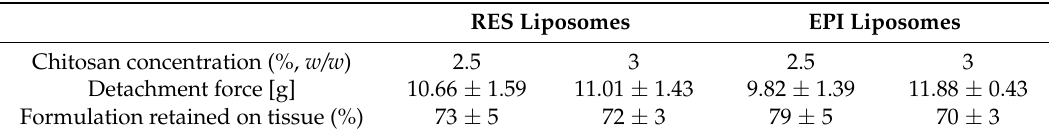
Results are expressed as mean ± SD ( n =